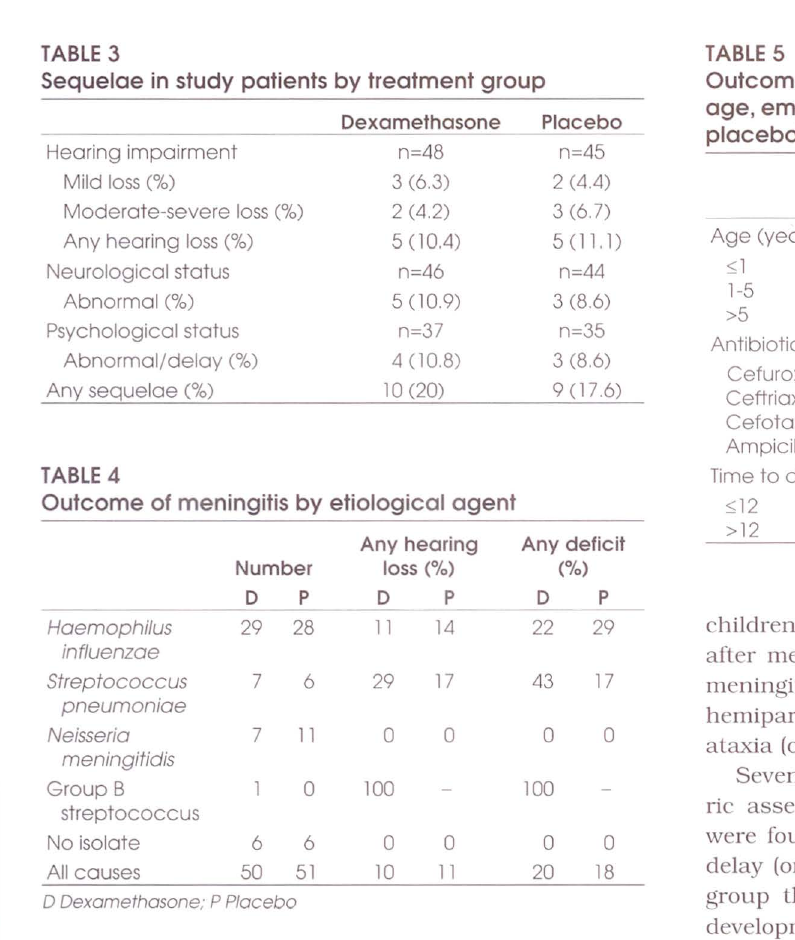
Sequelae in study patients by treatment group